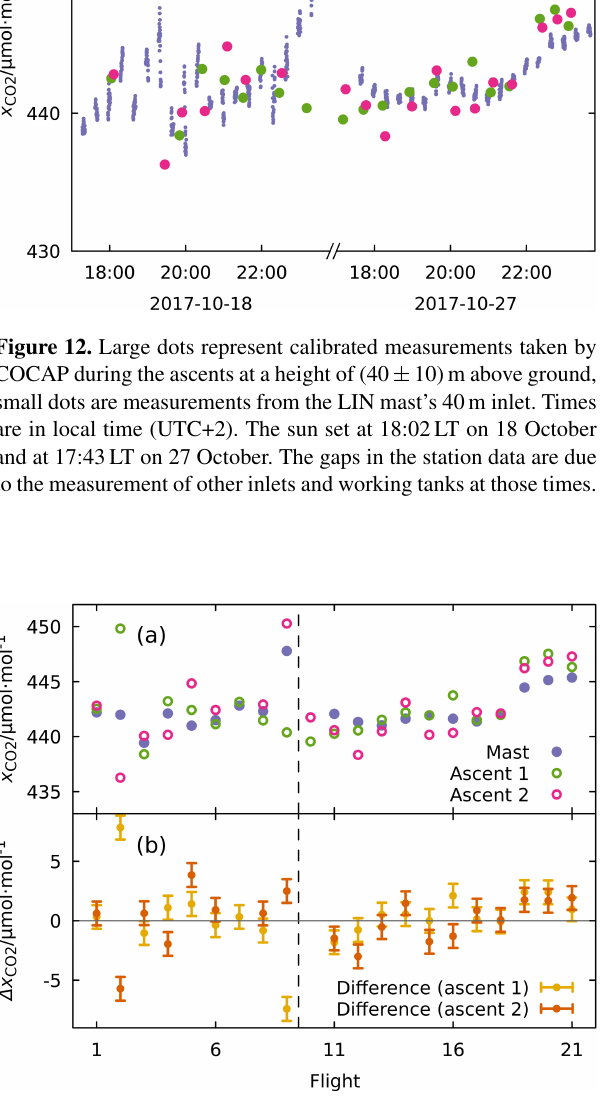
Figure 13. (a) Data from COCAP are same as in Fig 12. Measure- ments from the mast’s 40m inlet have been averaged over a period that starts 20min before and ends 20min after the respective flight. No measurements from the mast are available for flight 10 because calibration cylinders have been measured at this time. (b) x CO 2 measured by COCAP minus x CO measured by LIN. Error bars 2 indicate the noise level of COCAP’s CO 2 sensor after deconvolu- tion (see text). Flights 1 through 9 were carried out on 18 October, flights 10 through 21 on 27 October (indicated by dashed vertical